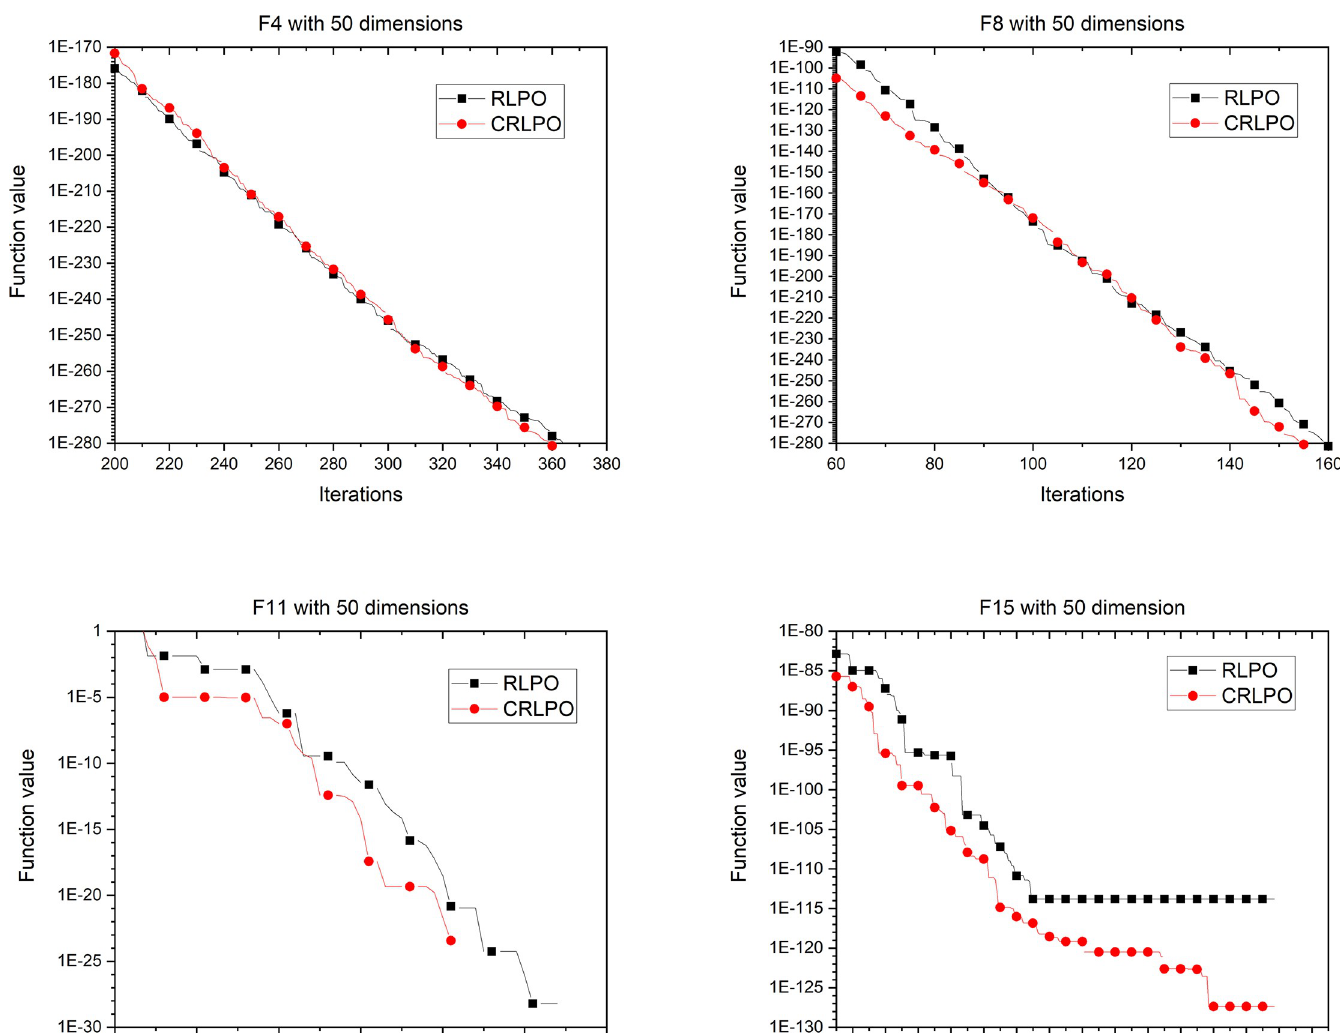
Fig 13. Convergence graph of CRLPO on 4 representative benchmark functions with 50